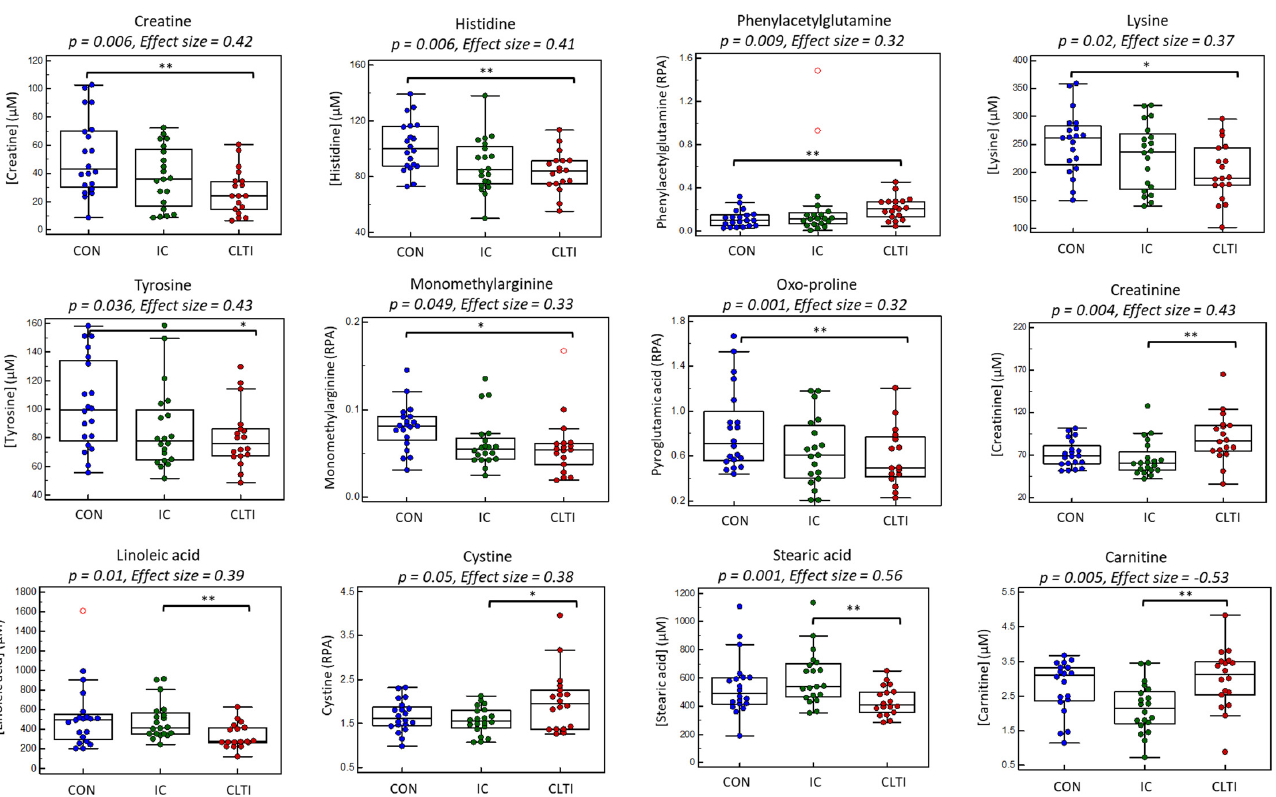
Figure 4. Box–whisker plots illustrating di ff erences in the twelve top-ranked serum metabolites compared between the critical limb-threatening ischemia (CLTI) patients ( n = 18), matched intermittent claudication (IC) patients ( n = 20) and the non-PAD controls ( n = 20). A one-way ANOVA test was performed to compare the means and identify significant changes in circulating metabolite concentrations between the three groups, as summarized in Table 2, where a polynomial contrasts analysis depicts most metabolites having a significant linear trend, proportional with disease progression. Planned contrasts were conducted by comparing non-PAD controls to PAD cases (IC + CLTI) (contrast 1; long bracket) followed by comparing IC to CLTI (contrast 2; short bracket) reflecting disease status and PAD progression, respectively where test significance is denoted as * p < 0.05 and ** p < 0.01. Serum stearic acid and carnitine were di ff erent between CLTI and IC when using an unpaired Student’s t -test after a FDR adjustment ( q < 0.05). Serum metabolites responses in terms of absolute concentrations ( µ M), or relative peak area (RPA) if standards were not